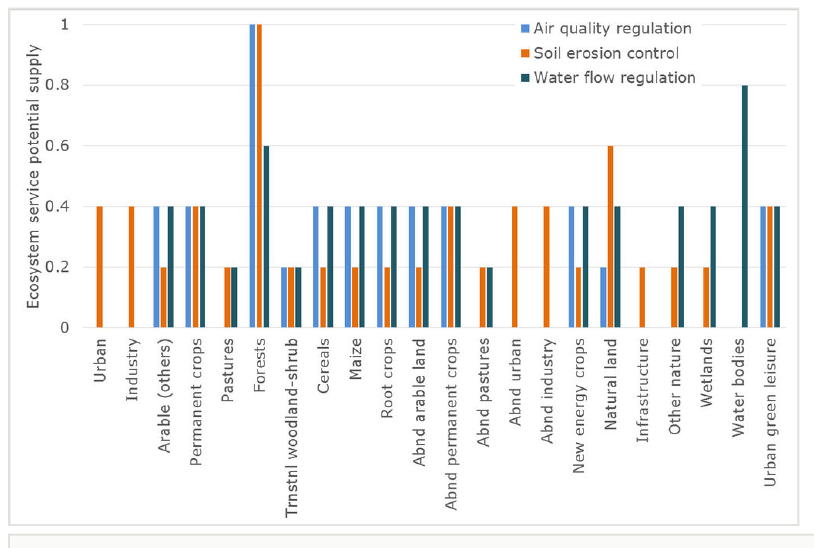
Figure 4. Relative capacity (y-axis) of LULC types (x-axis) to supplying regulating ES (air quality regulation, soil erosion control and water fl ow regulation). LULC types are de fi ned as in LUISA (Baranzelli et al. 2014), scores are based on a modi fi ed version of the ecosystem service potential matrix of Burkhard et al. (2014). See main text for additional details. Abnd: Abandoned; Trnstnl: